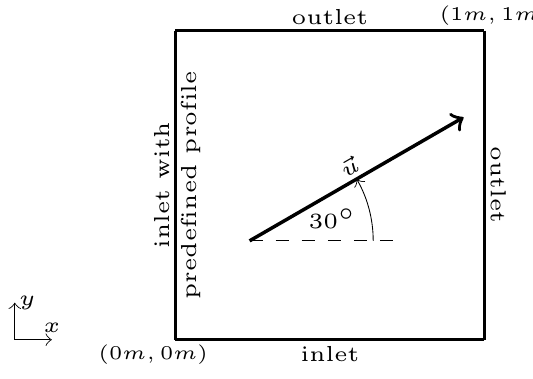
Figure 11. Setup for the two-dimensional transport of prescribed